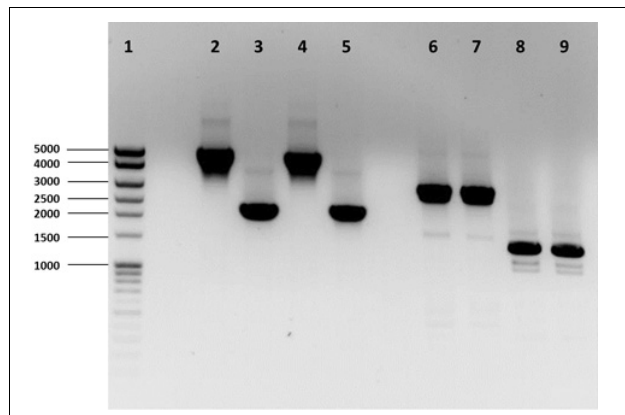
FIGURE 1 | PCR analysis of H26, (cid:2) dhaKLM , (cid:2) glpK , and (cid:2) dhaKLM (cid:2) glpK . Analysis examined presence or absence of the dhaKLM operon (lanes 2–5) and glpK (lanes 6–9). Lane 1 contained exACTGene Mid Range Plus DNA Ladder (Fisher Scientific). Lanes 2 and 6 contained amplicons from H26. Lanes 3 and 7 contained amplicons from (cid:2) dhaKLM . Lanes 4 and 8 contained amplicons from (cid:2) glpK . Lanes 5 and 9 contained amplicons from (cid:2) dhaKLM (cid:2) glpK